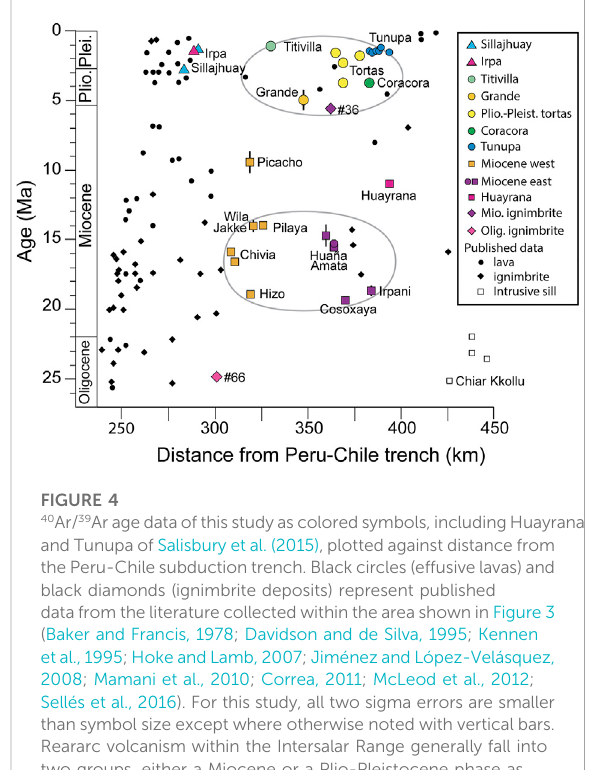
FIGURE 4 40 Ar/ 39 Aragedataofthisstudyascoloredsymbols,includingHuayrana and Tunupa of Salisbury et al. (2015), plotted against distance from thePeru-Chilesubductiontrench.Blackcircles(effusivelavas)and black diamonds (ignimbrite deposits) represent published datafrom theliteraturecollected within theareashown inFigure 3 (Baker and Francis, 1978; Davidson and de Silva, 1995; Kennen etal.,1995;HokeandLamb,2007;JiménezandLópez-Velásquez, 2008; Mamani et al., 2010; Correa, 2011; McLeod et al., 2012; Sellés et al., 2016). For this study, all two sigma errors are smaller than symbol size except where otherwise noted with vertical bars. Reararc volcanism within the Intersalar Range generally fall into two groups, either a Miocene or a Plio-Pleistocene phase as shown bygreyoutlines. Mioceneeruptions are further divided into western and eastern